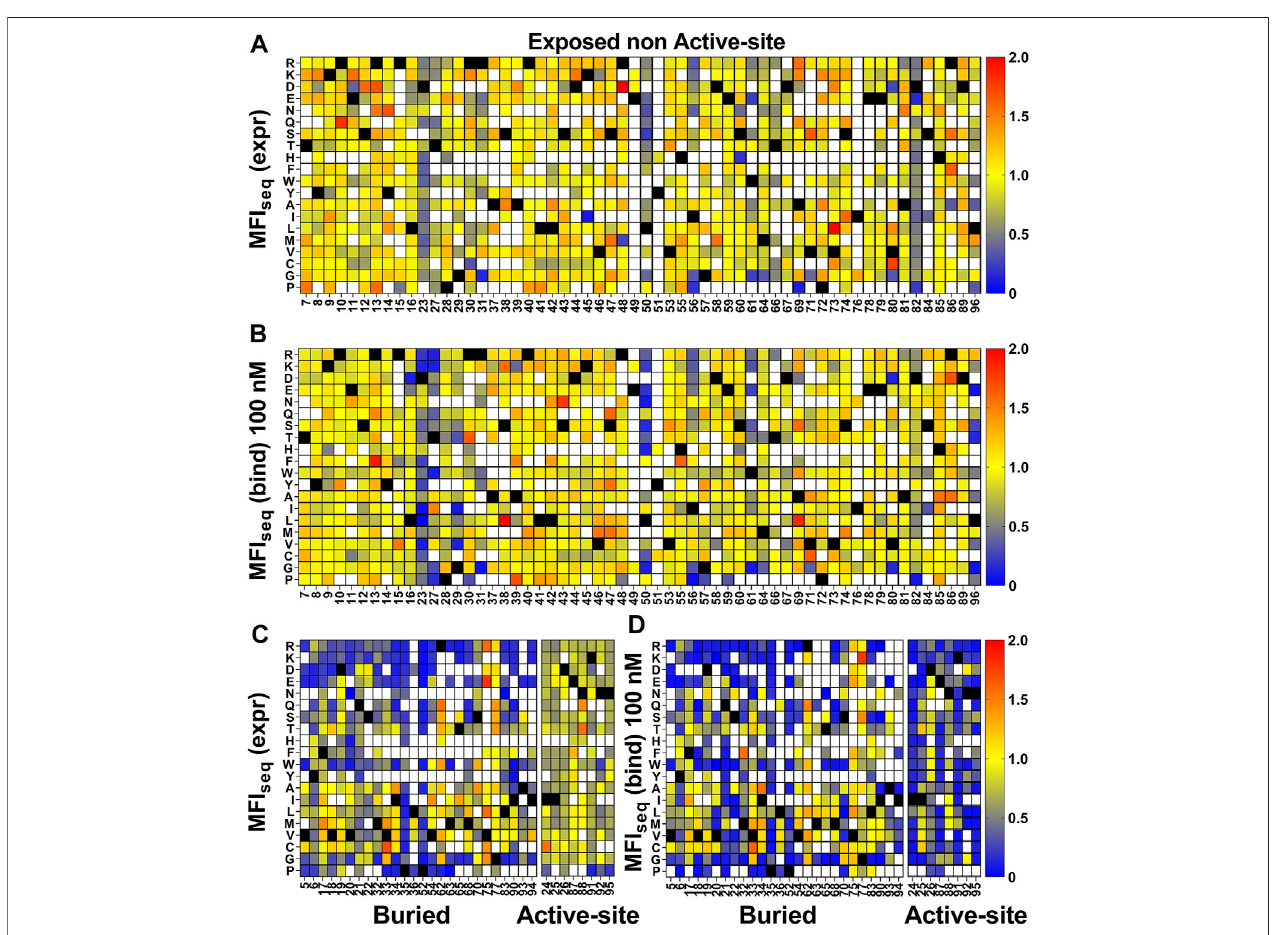
FIGURE3| Heatmap ofnormalizedMFI seq valuesforCcdBmutants. MFI seq valueofmutant wasdividedbytheMFI seq valueofWT tonormalize it. (A) MFI seq (expr) and (B) MFI seq (bind)at 100 nMGyrA14 forexposednonactive-site residues. (C) MFI seq (expr) and (D) MFI seq (bind)forburiedandactive-siteresidues.Exposed,buried (PDB ID:3VUB) and active-site (PDB ID:1X75) residues are segregated based on the crystal structure. Residues which had accessibility greater than 10% were considered exposed, all remaining residues were considered buried, and active-site mutants in contact with GyrA14 were identi fi ed as explained the